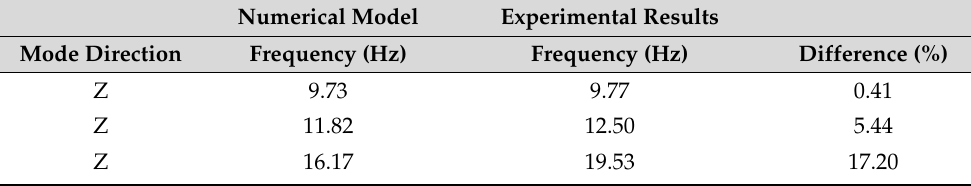
Table 9. Comparison between numerical (nominal model) and experimental